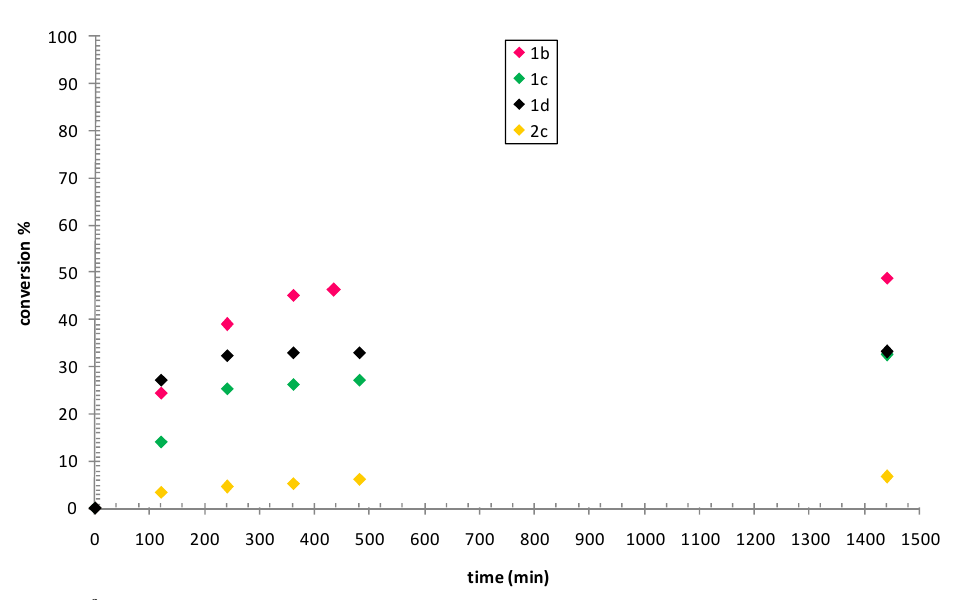
Figure 6. Styrene dimerization: effect of the precatalyst.